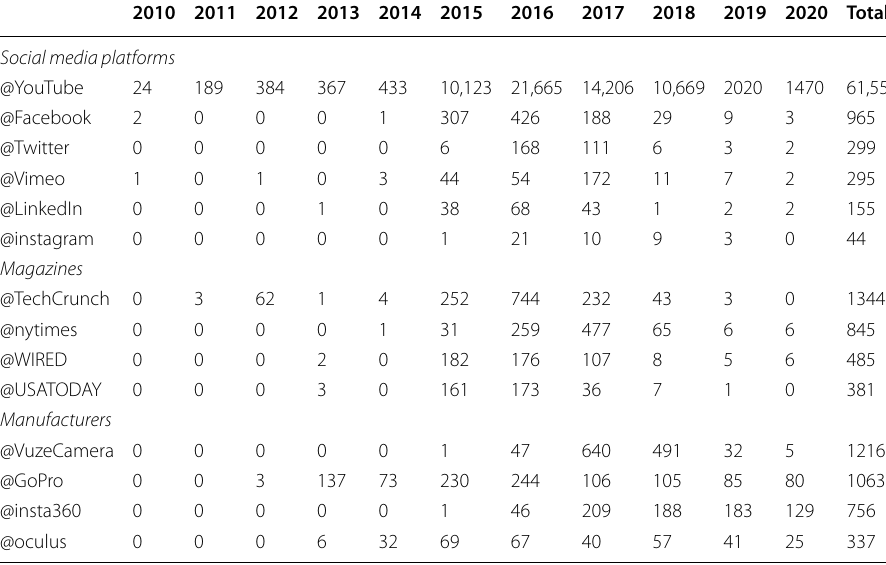
Table 4 Frequency of the most mentioned social media platforms, magazines and